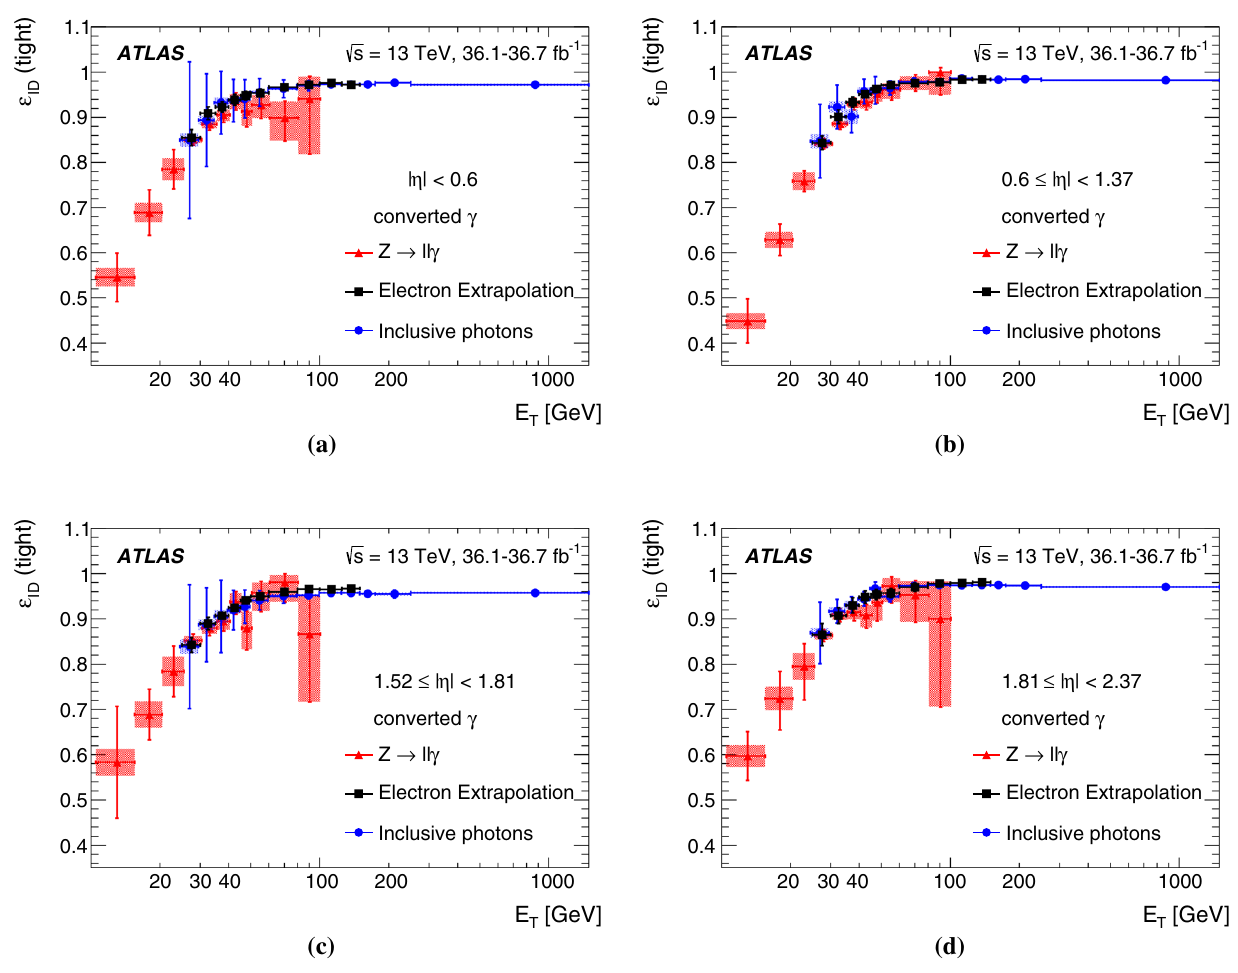
Fig. 8 Comparison of the data-driven measurements of the identifi- cation efficiency for converted photons as a function of E T , for the four pseudorapidity intervals a | η | < 0 . 6, b 0 . 6 ≤ | η | < 1 . 37, c 1 . 52 ≤ | η | < 1 . 81, and d 1 . 81 ≤ | η | < 2 . 37. The error bars represent